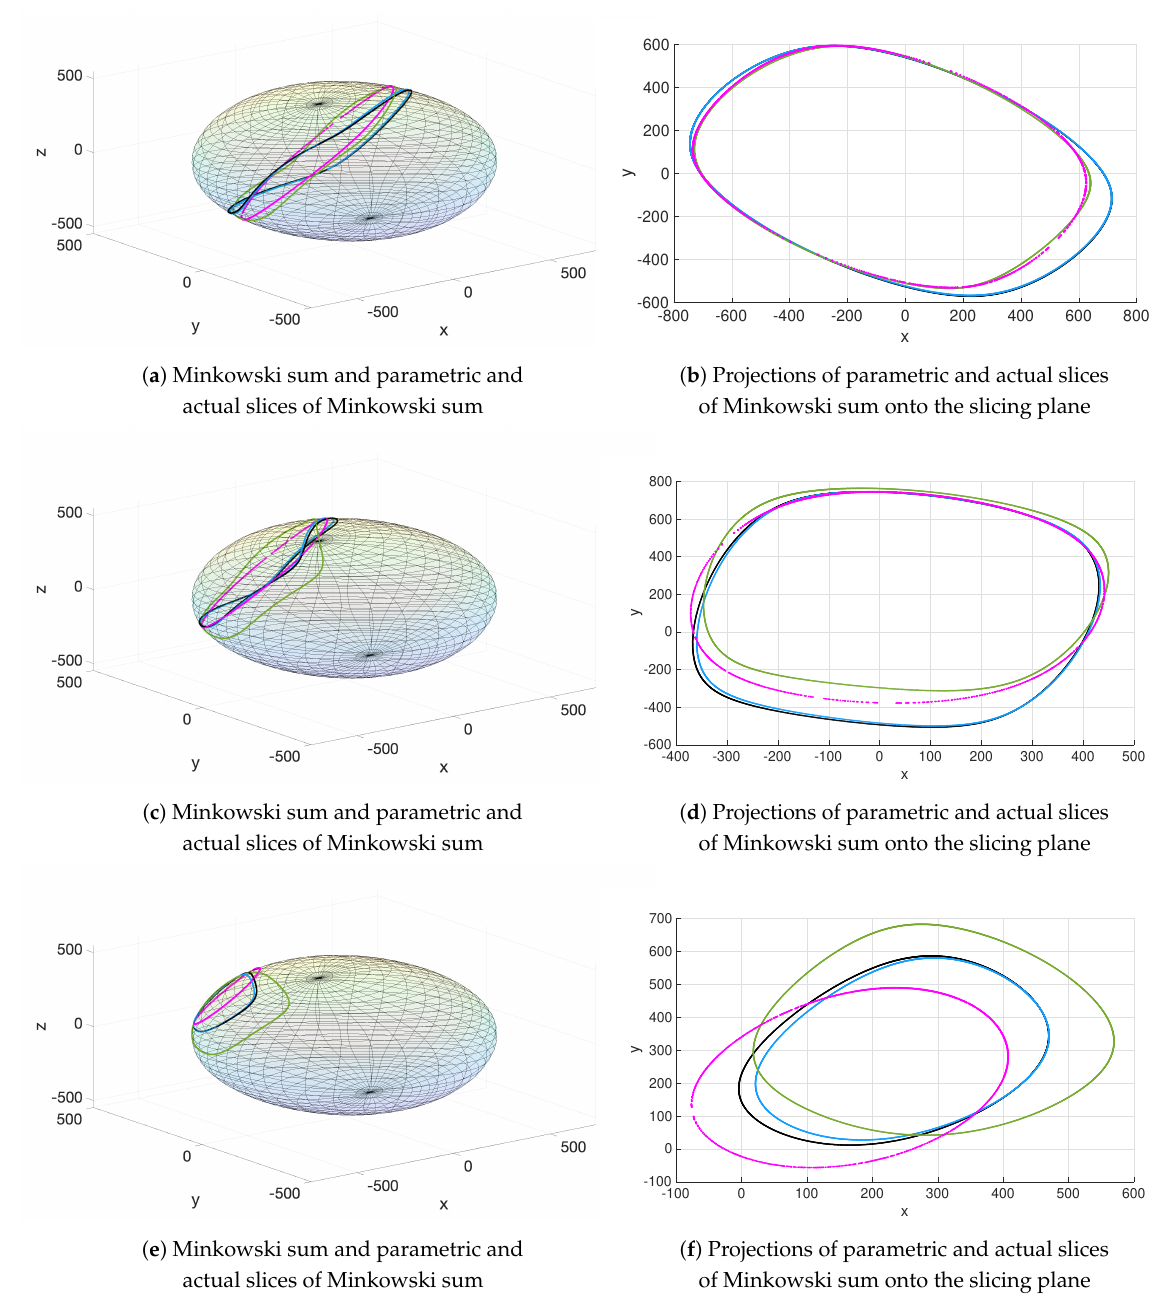
of Minkowski sum onto the slicing plane Figure 4. Parametric slices of Minkowski sum for a particular Minkowski sum and orientation of the slicing plane but at different heights h , computed by: MVOE from minimization of (7) (black), John’s inner bound in (12) (blue), second eigenvalue λ 2 ( A T A i ) in (16) (green). The actual slice of Minkowski sum is pink. Figure 5 enlightens that the weak consistency of the slice approximations with the actual one, observed in Figure 4c–f, is in fact an indirect consequence of the distance of the slicing plane (actual slice) from the center of the Minkowski sum. This figure shows a similar slicing sample to Figure 4a,b, such that the same Minkowski sum is sliced up by a plane at the same height h but with different orientation. Although, the slicing plane is in the same distance h from the Minkowski center, as in Figure 4a,b, the parametric slices